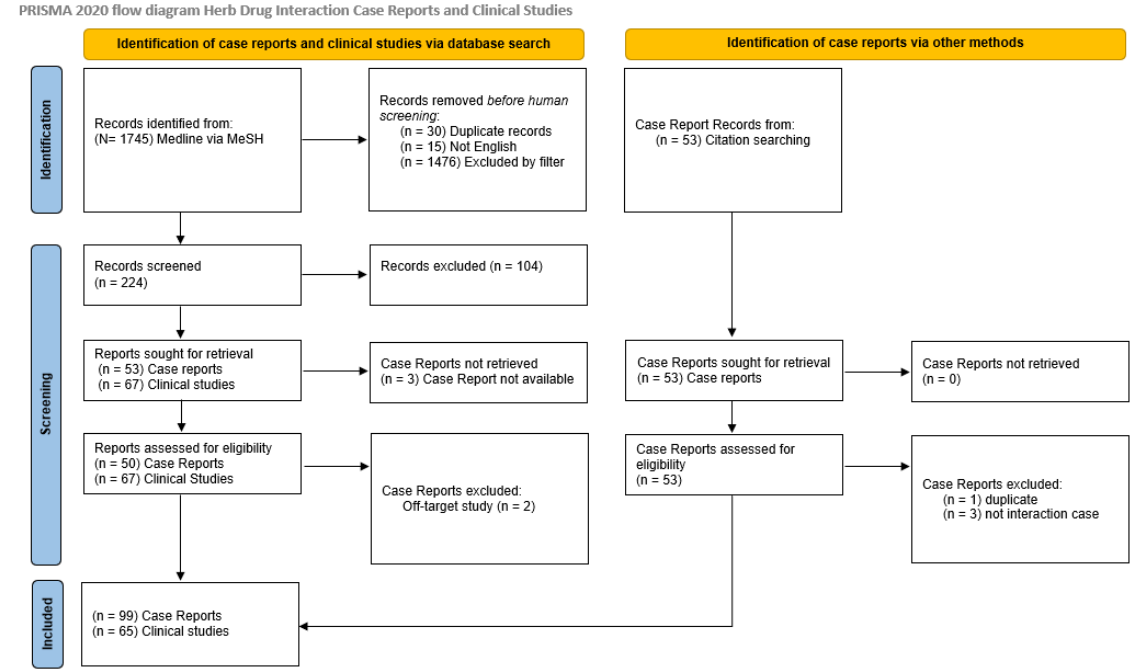
Figure 1. PRISMA diagram [43].